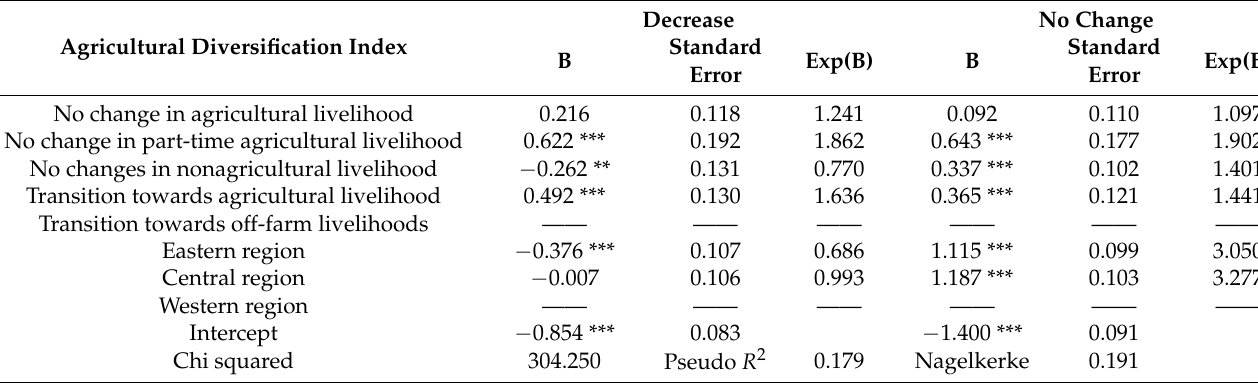
Table 5. Parameter estimation of the